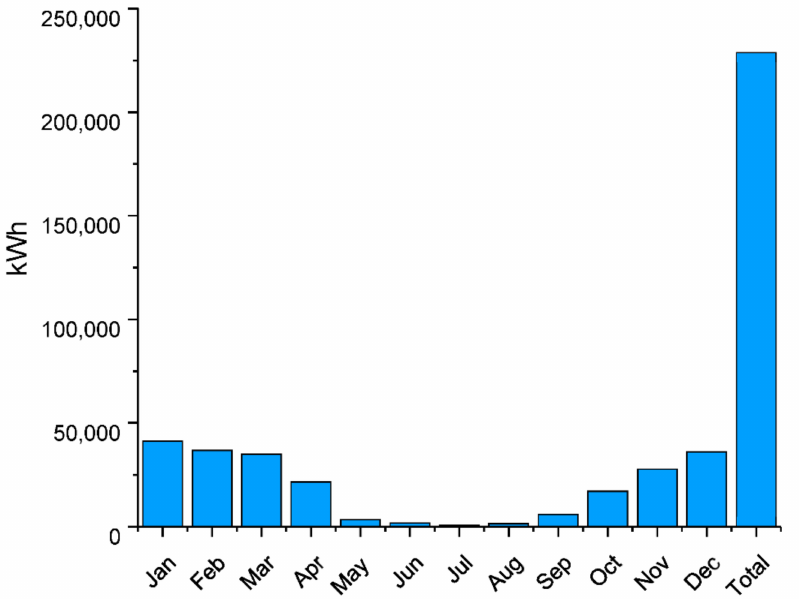
Figure 10. The building energy bills for district heating in 2018, collected from Gavlefastigheter